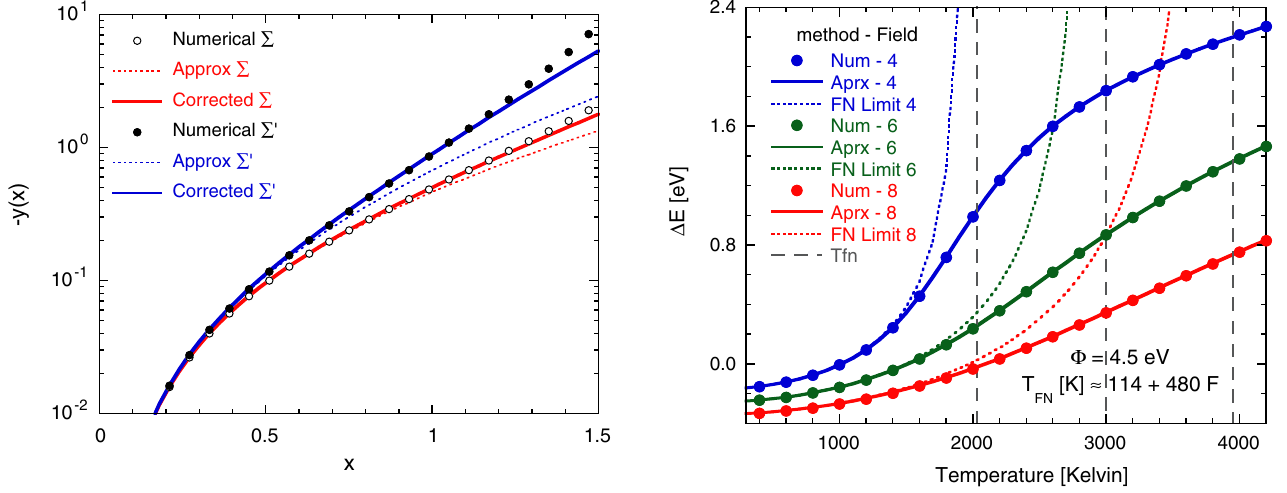
FIG. 13. (Color) Comparison of a numerical evaluation of (cid:3) (cid:3) x (cid:4) compared to truncating the series expansion of Eq. (15) at the second term (approximately (cid:3) ) and Eq. (16) (corrected (cid:3) , or ): it is seen that (cid:3) performs very well through the n (cid:6) 1 (cid:3) a a